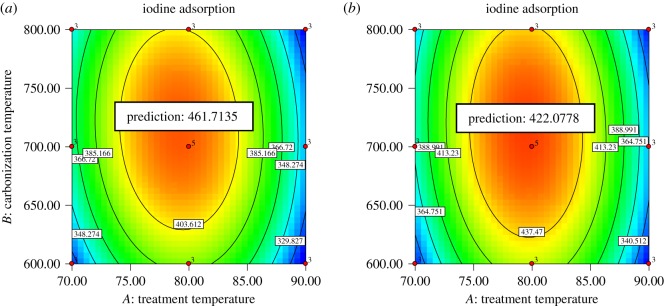
Response surface and contour plot of carbonization temperature versus treatment temperature: (a) CS bioadsorbent and (b) PKS bioadsorbent.